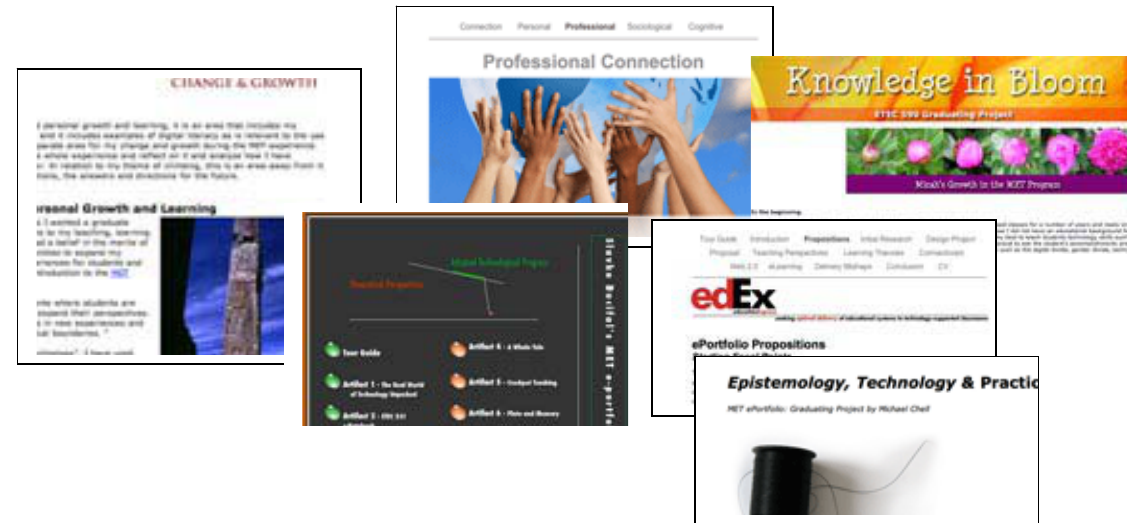
Figure 2. A collage of ePortfolios from Summer